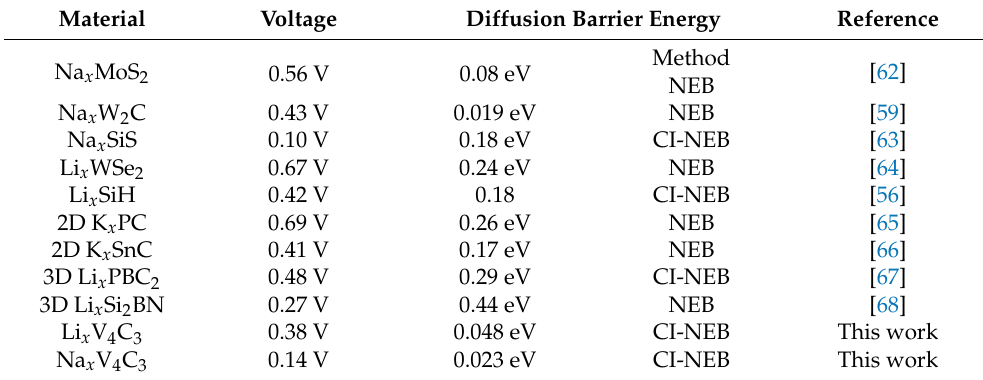
Table 2. Comparison of voltages and energy barriers with Li x V 4 C 3 and Na x V 4 C 3